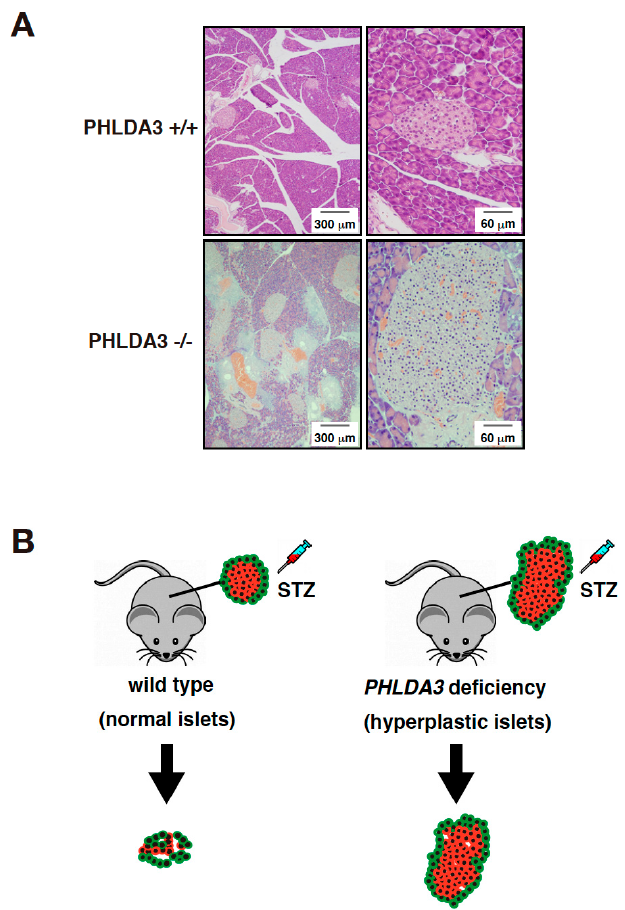
Figure 3. PHLDA3 ‐ deficient mice exhibit islet hyperplasia and resistance of β cells to apoptosis. ( A ) HE staining of islets from wild type and PHLDA3 ‐ deficient 10 month ‐ old mice. ( B ) Apoptosis of β cells is observed in wild type mice treated with streptozotocin (STZ) but is suppressed in PHLDA3 ‐ deficient mice.